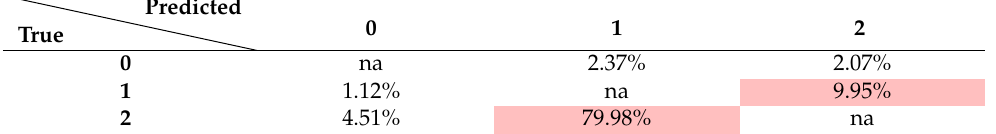
Table 8. Wrong Prediction Matrix for